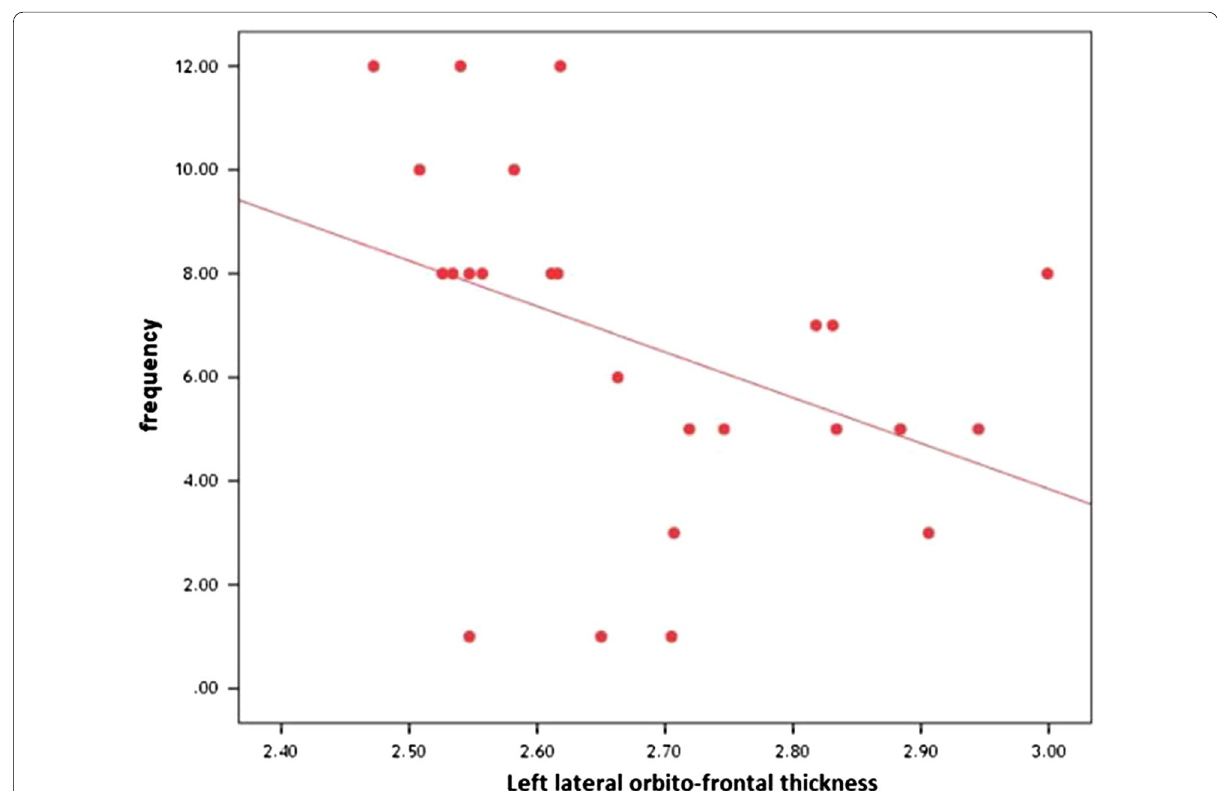
Fig. 3 Negative significant correlation between frequency of attacks and left lateral orbitofrontal